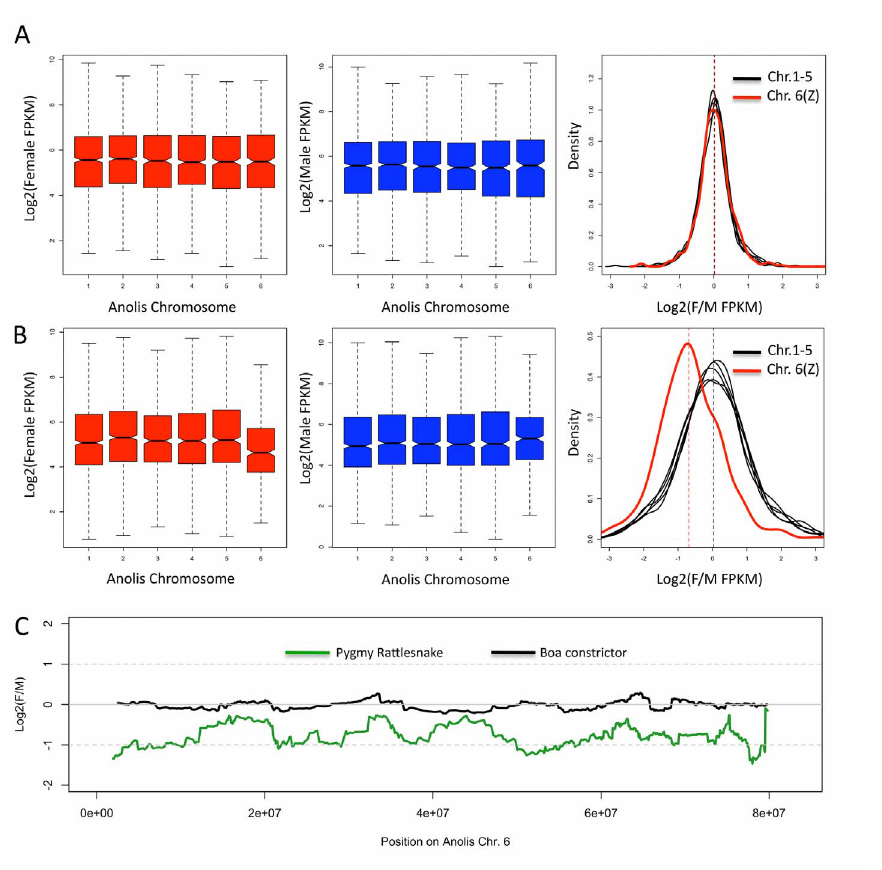
Figure 5. Log 2 of expression in female, log 2 of expression in male, and log 2 of female over male expression, for the different macrochromosomes of boa (A) and pygmy rattlesnake (B). FPKM values were obtained for each gene using Cufflinks. Genes were assigned to different chromosomes according to their location in the Anolis genome. (C) log 2 of female over male expression along chromosome 6 of Anolis (Z of snakes), using a sliding window size of 30 genes.